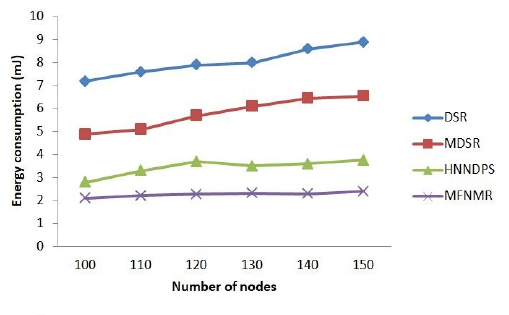
Figure 2. Energy Consumption Analysis based on Number of Nodes.